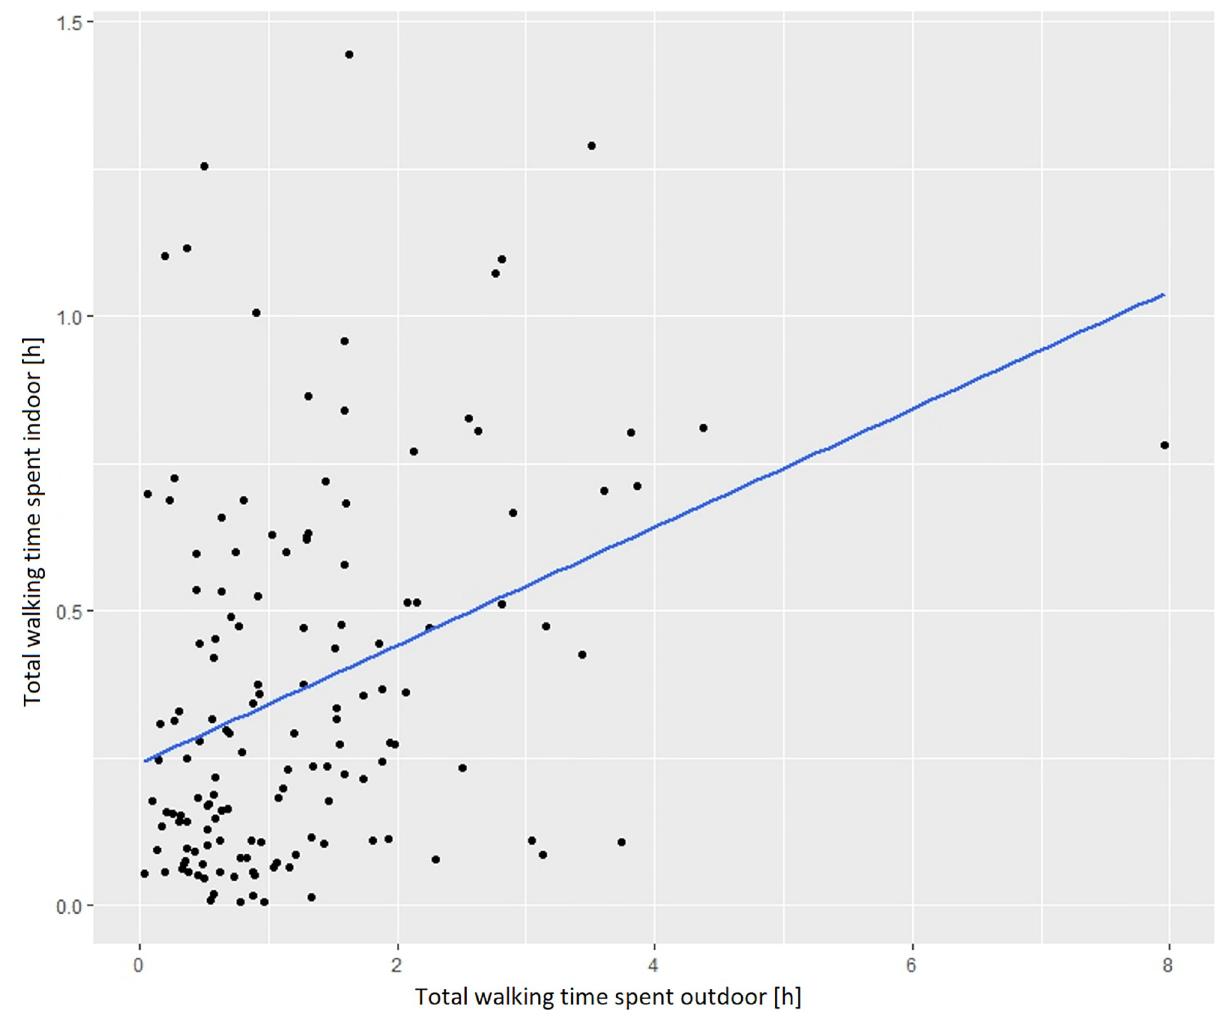
Fig 8. Relationship between indoor and outdoor walking